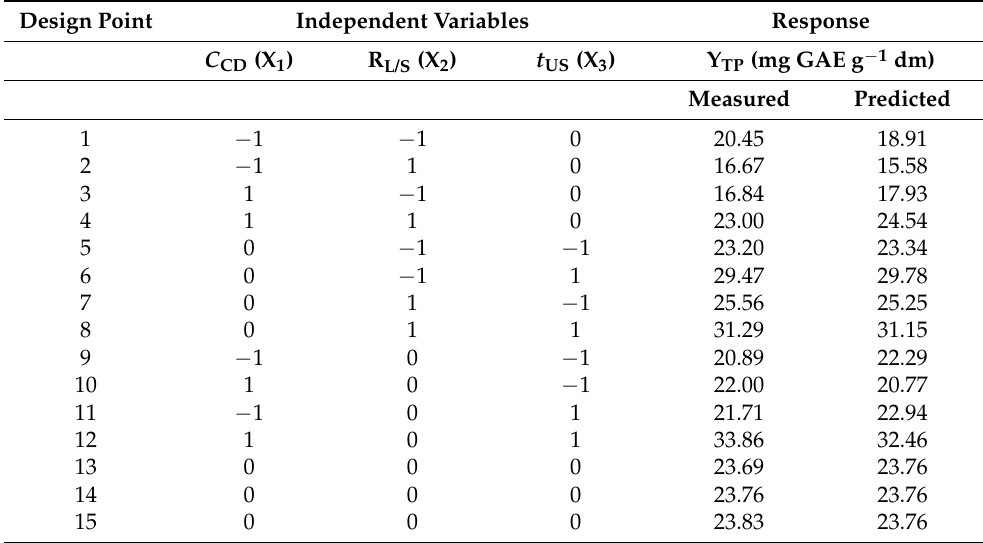
Table 2. The experimental design used to implement response surface methodology, displaying all points considered and the measured and predicted values of the response.